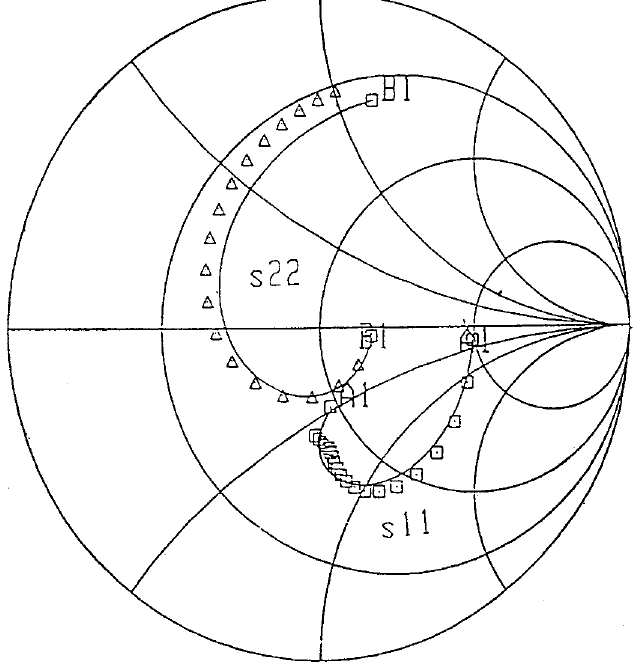
FIGURE 7 The measured and simulated S 11 , S 22 from 130MHz to